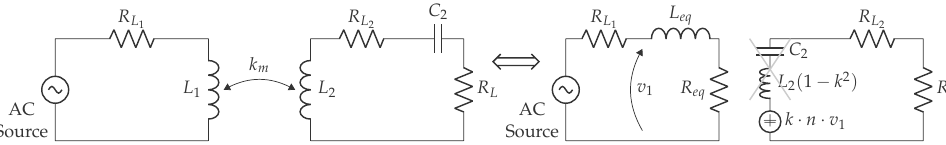
Figure 5. Canceling of the secondary leak inductance. The figure is composed of the equivalent model with a voltage-controlled secondary voltage source, with n being the inductance ratio